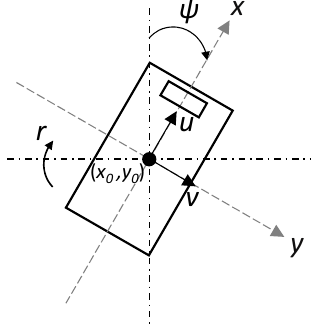
Figure 4. Degrees of freedom of the APC.